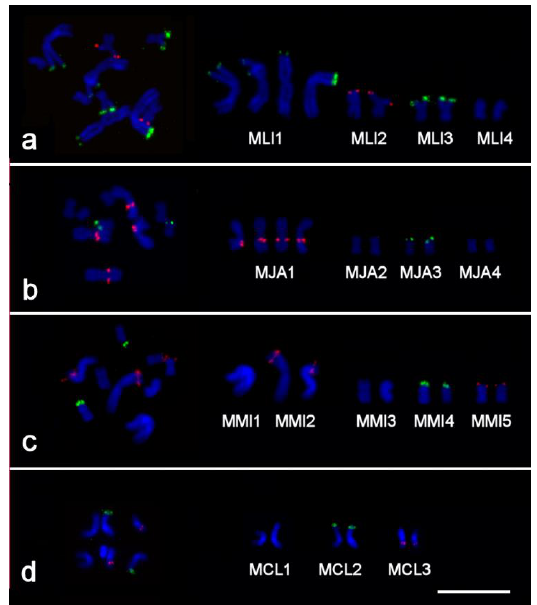
Figure 4. Two-color fluorescent in situ hybridization (FISH) with probes specific to 28S rDNA (green) and 5S rDNA (red) on chromosomes of four Macrostomum species: ( a ) inbred DV1/10 line of M. lignano and outbred cultures of ( b ) M. janickei , ( c ) M. mirumnovem, and ( d ) M. cliftonensis . Chromosomes were counter-stained with DAPI (blue). Scale bar 10 µm.